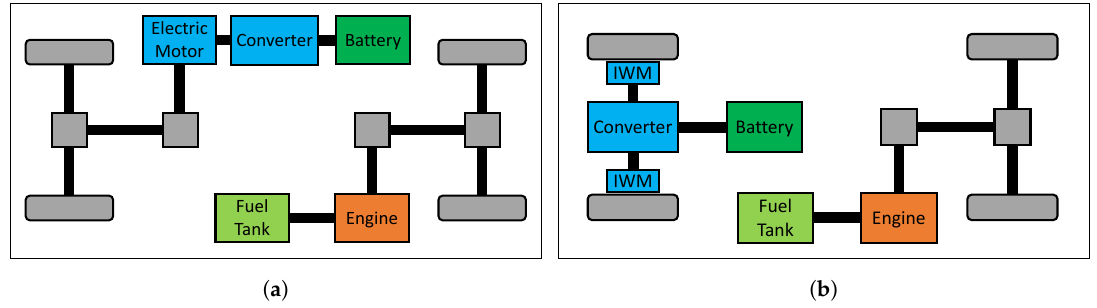
Figure 1. Possible architectures for a TTR HEV. ( a ) One axle is driven by the internal combustion engine, while the other is driven by an electric motor; ( b ) Electric motors are mounted directly inside the wheels (In-Wheel Motor).